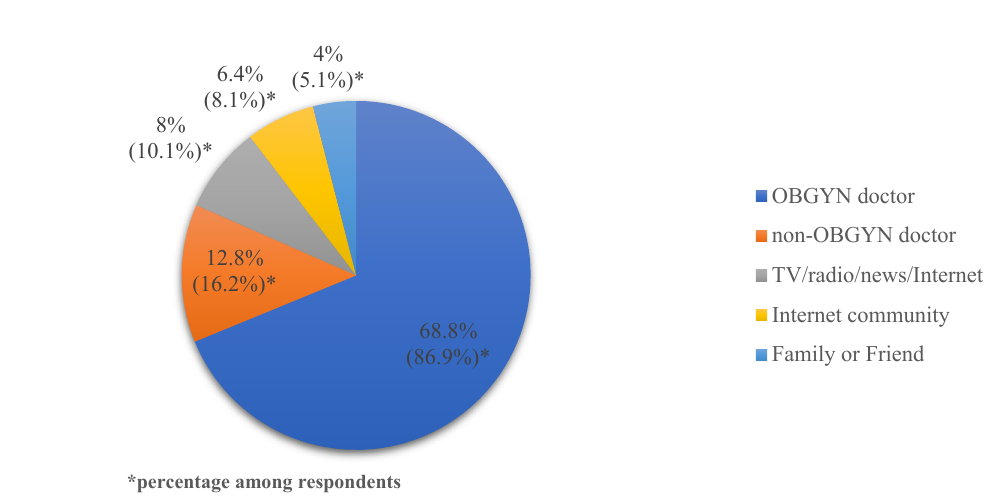
Figure 2. Information and recommendation routes that affect future COVID-19 vaccination. OBGYN, obstetrics and gynecology, TV, Television.